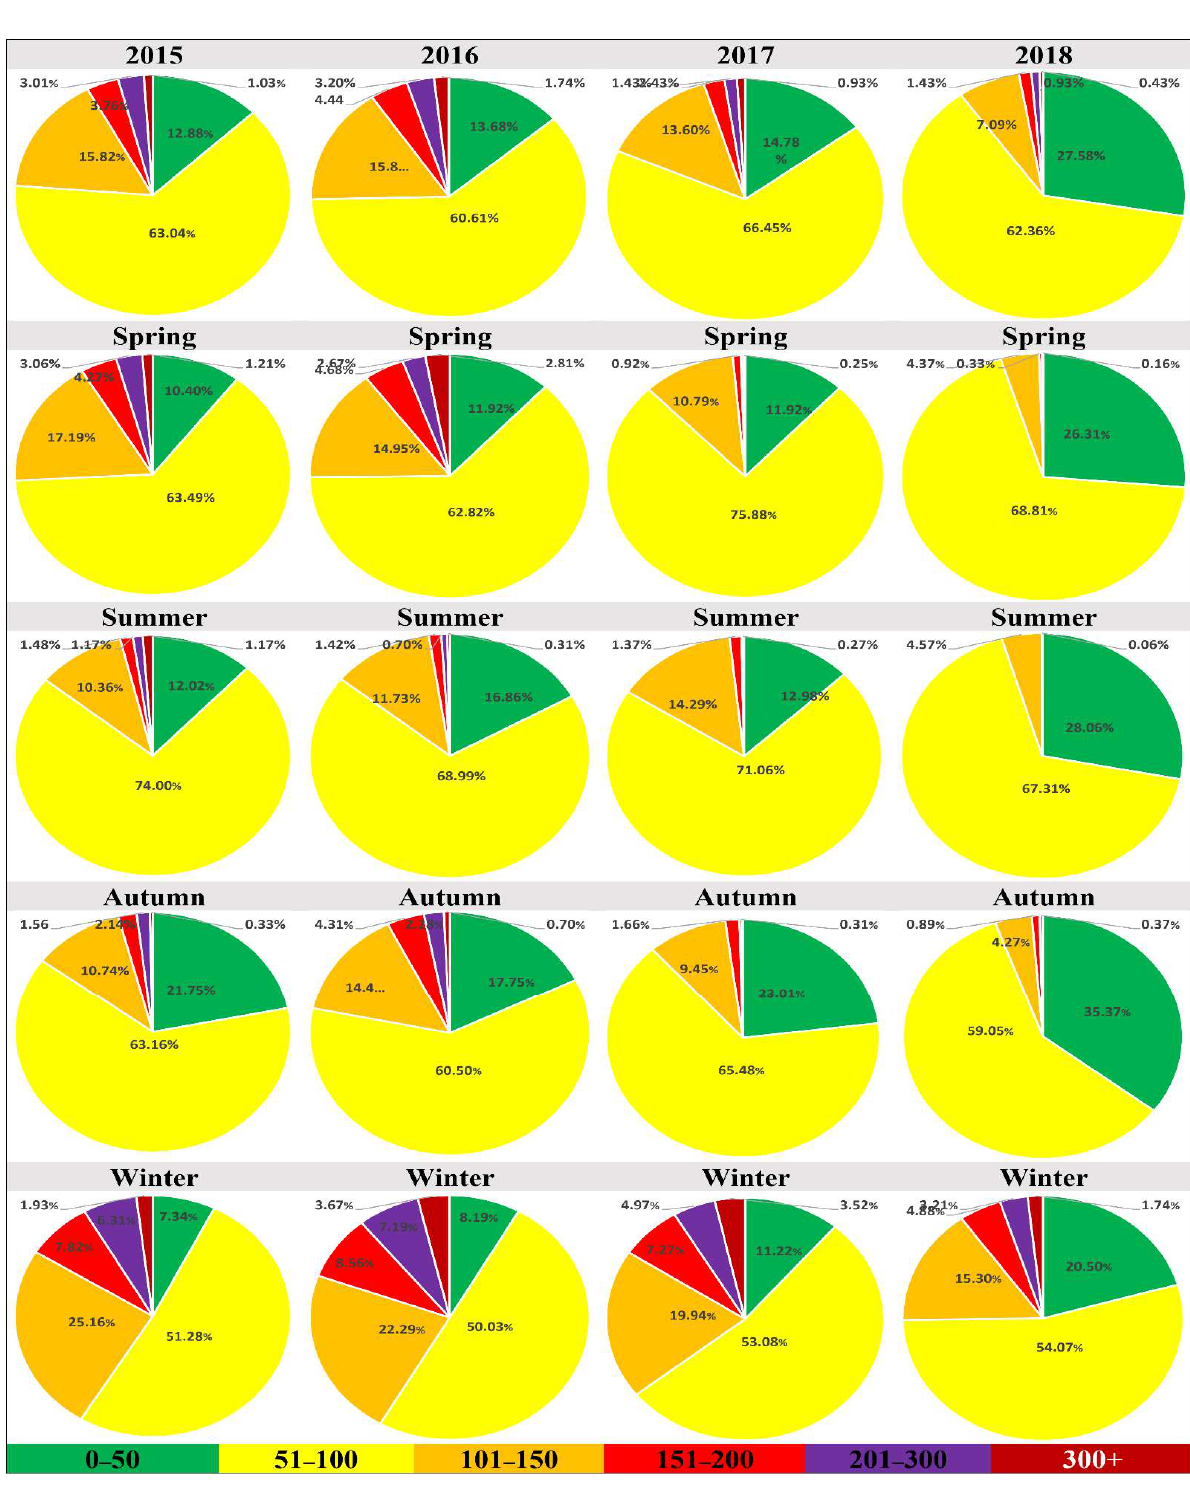
Figure 7. The annual (1st row) and seasonal (spring (2nd row), summer (3rd row), autumn (4th row), and winter (5th row)) distribution of AQ class, e.g., Class I (0–50, good, green), Class II (51–100, moderate, yellow), Class III (101–150, unhealthy for a sensitive group, orange), Class IV (151–200, unhealthy for all, red), Class V (001-300, very unhealthy, purple), and Class VI (300+, hazardous, maroon) in northwest China (NWC) between 2015 and